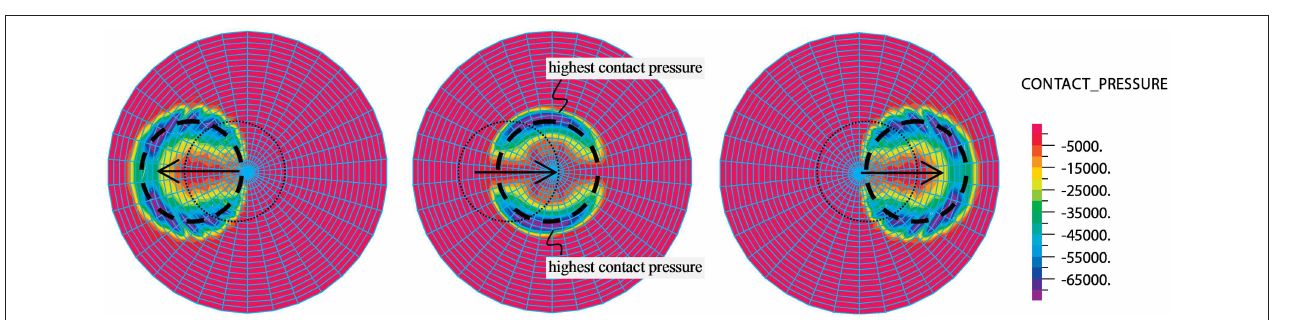
FIGURE 11 | Contour plots of contact pressure of CSS prototype analyzed in De Domenico et al.